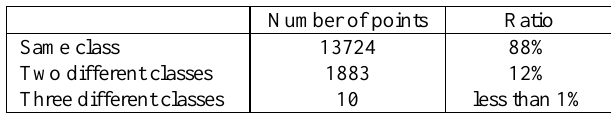
Table 3: Number of classes on point base